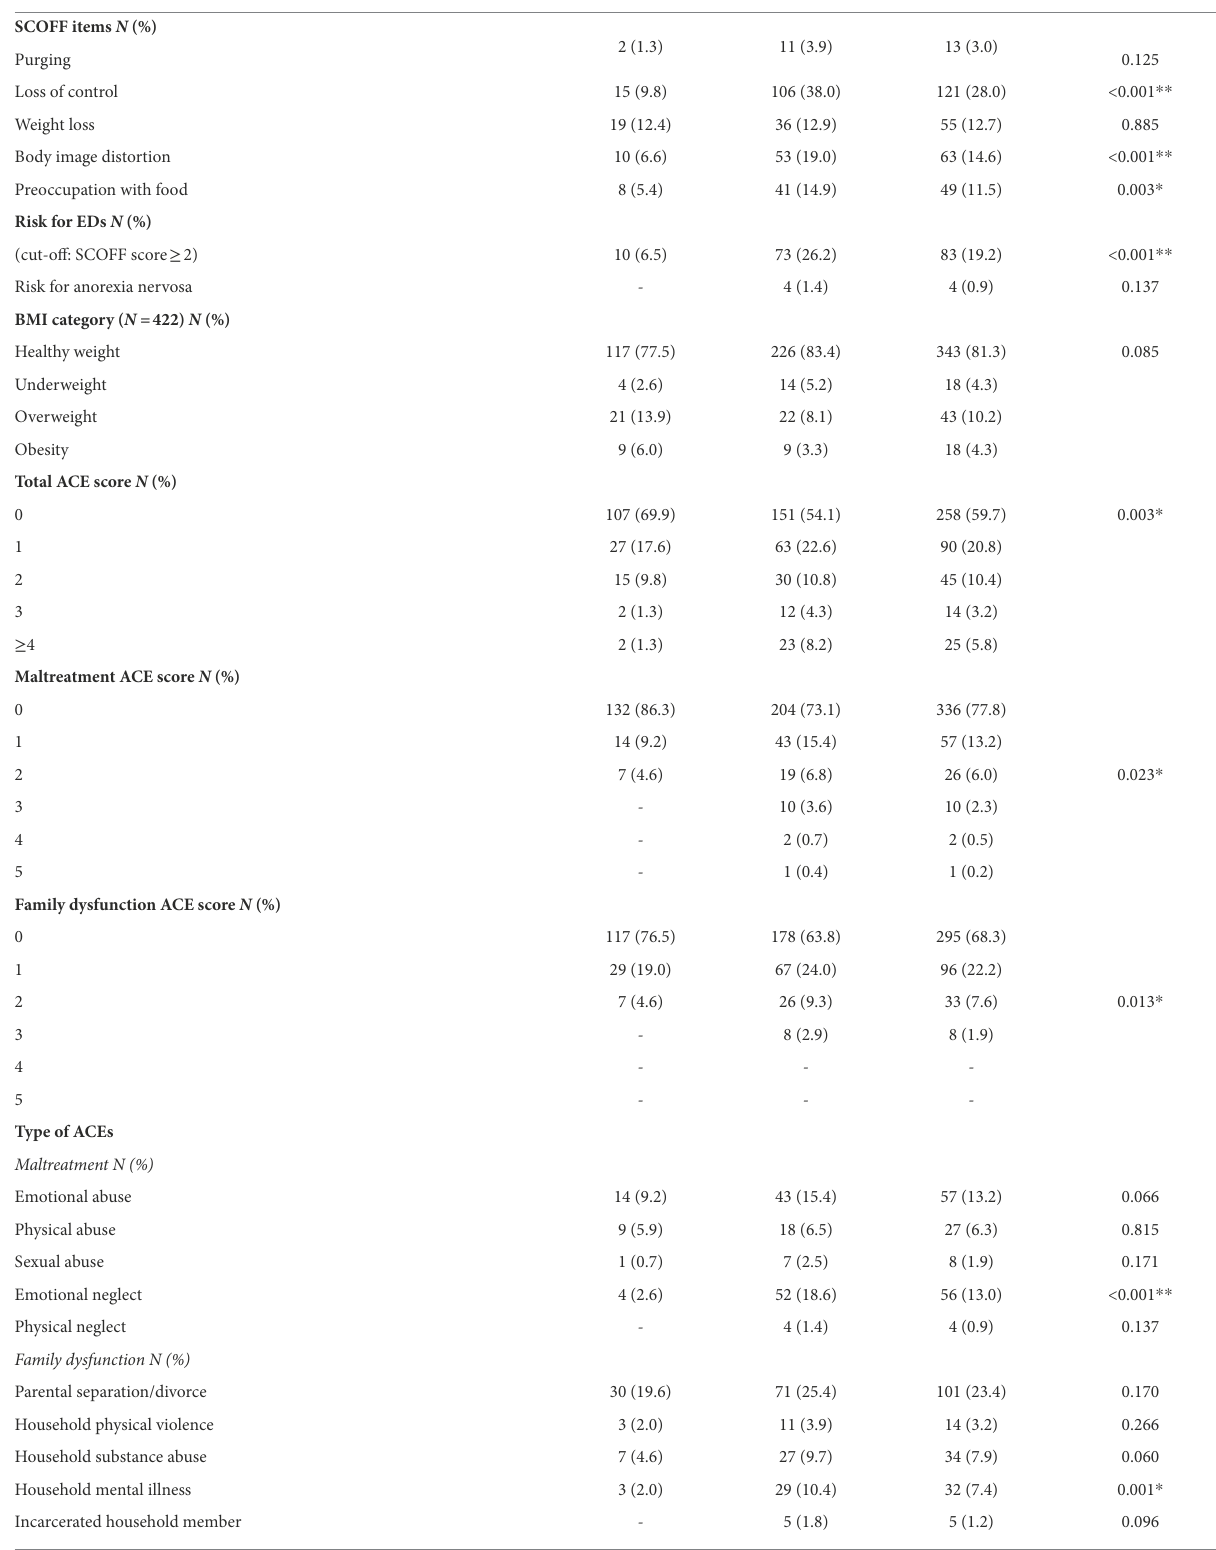
TABLE 2 Frequency of risk for eating disorders (EDs), BMI categories, and adverse childhood experiences (ACEs) in the sample overall and by gender. Boys ( N = 153) Girls ( N = 279) Total ( N = 432) p -value